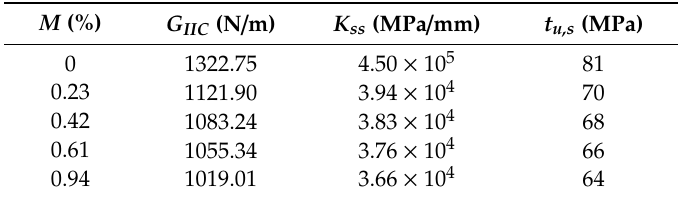
Table 3. Cohesive parameters used for di ff erent moisture content